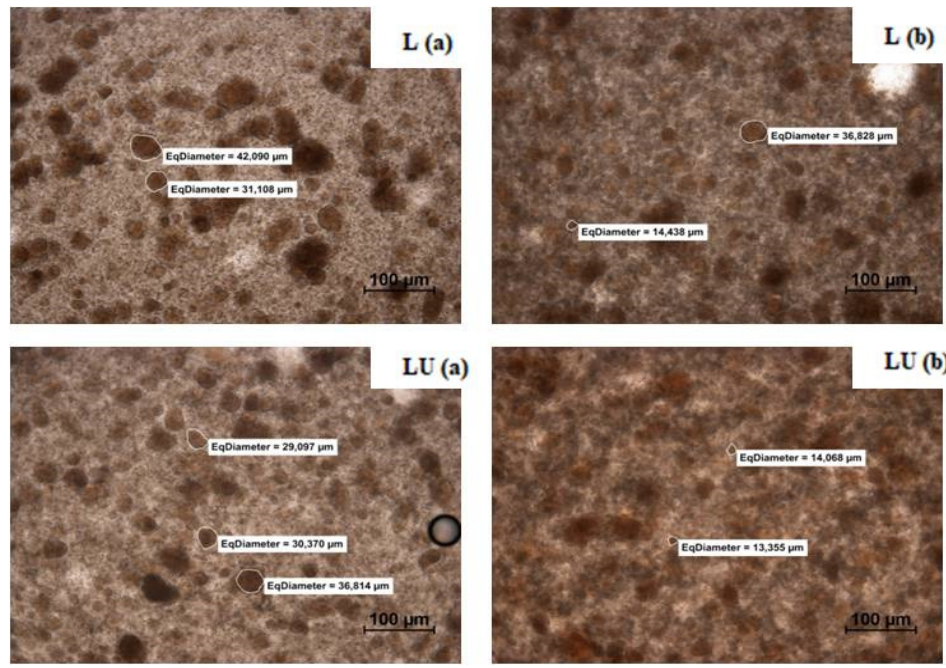
Figure 5. The microscopy analysis of ice cream mixes before ( a ) and after maturation ( b ) (for 24 h; at 4 °C).